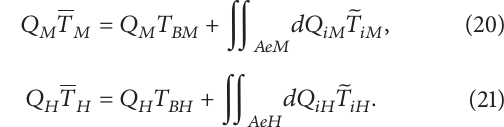
temperature stratification in the reservoir during a typical of the prototype and calculated temperature distribution in May as an example).